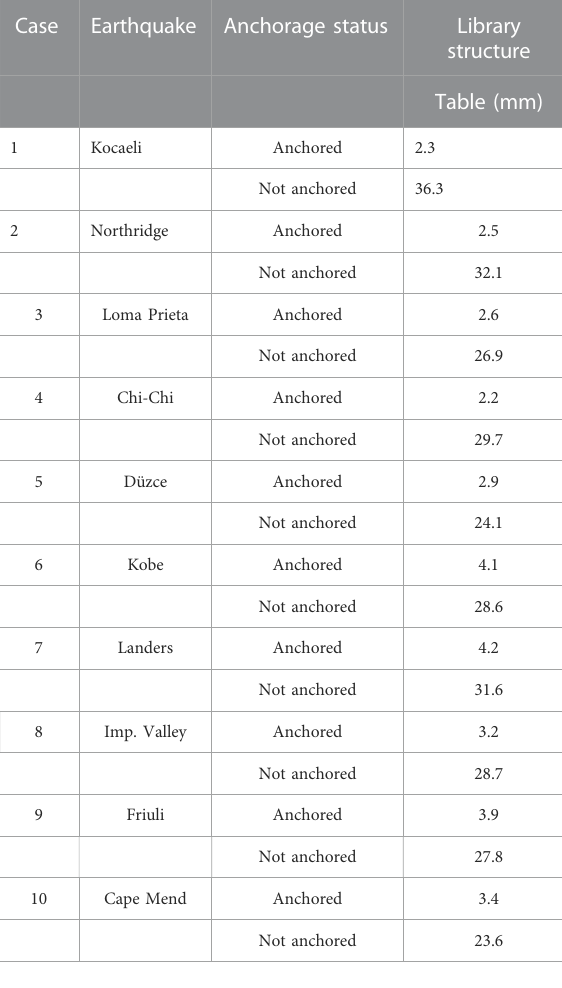
TABLE 4 Maximum seismic acceleration results for different NEs (Cavuslu, 2022).